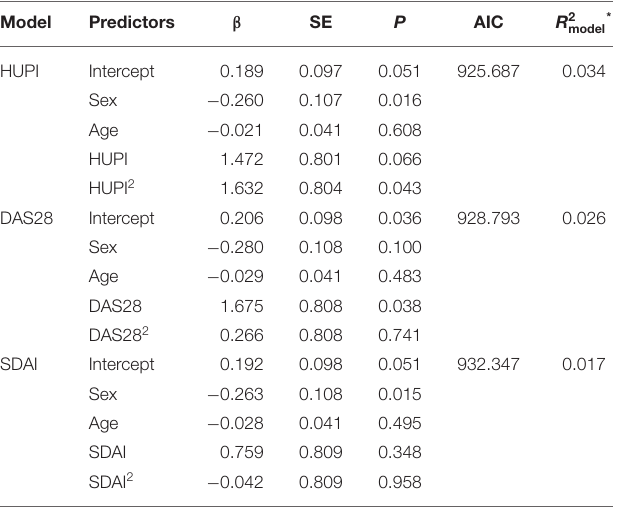
TABLE 3 | Models for radiographic progression in the ACT-RAY study comparing the performance of different indices. Model Predictors